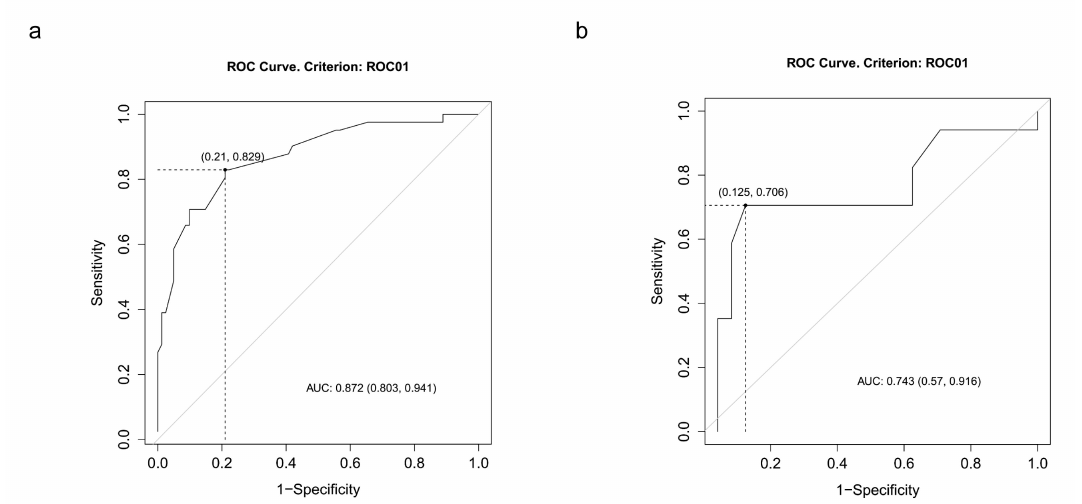
Figure 4. ROC curve. ( a ) Receiver operating characteristic (ROC) curve for residual displacement for the diagnosis of nonhealing fractures. ( b ) Receiver operating characteristic (ROC) curve for residual displacement for the discrimination between nonunion and delayed